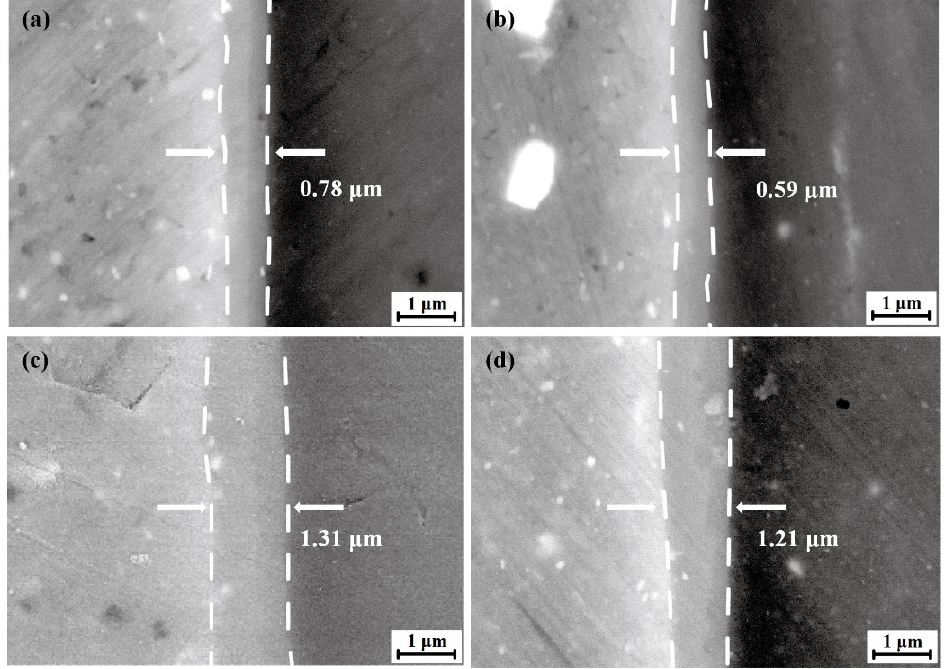
shoulder affect zone (SAZ) was higher than that in the SZ in both joints, as shown in Figure 7c,d. The IMCs thickness of SAZ in the FSW and SFSW joint were 1.31 µ m and 1.21 µ m due to SAZ probably suffering more frictional heat from the tool shoulder than SZ.